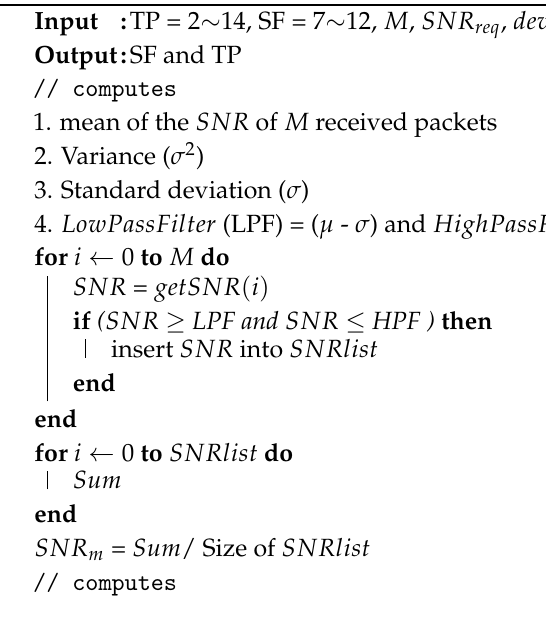
Algorithm 1: Proposed Gaussian filter-based adaptive data rate (G-ADR)